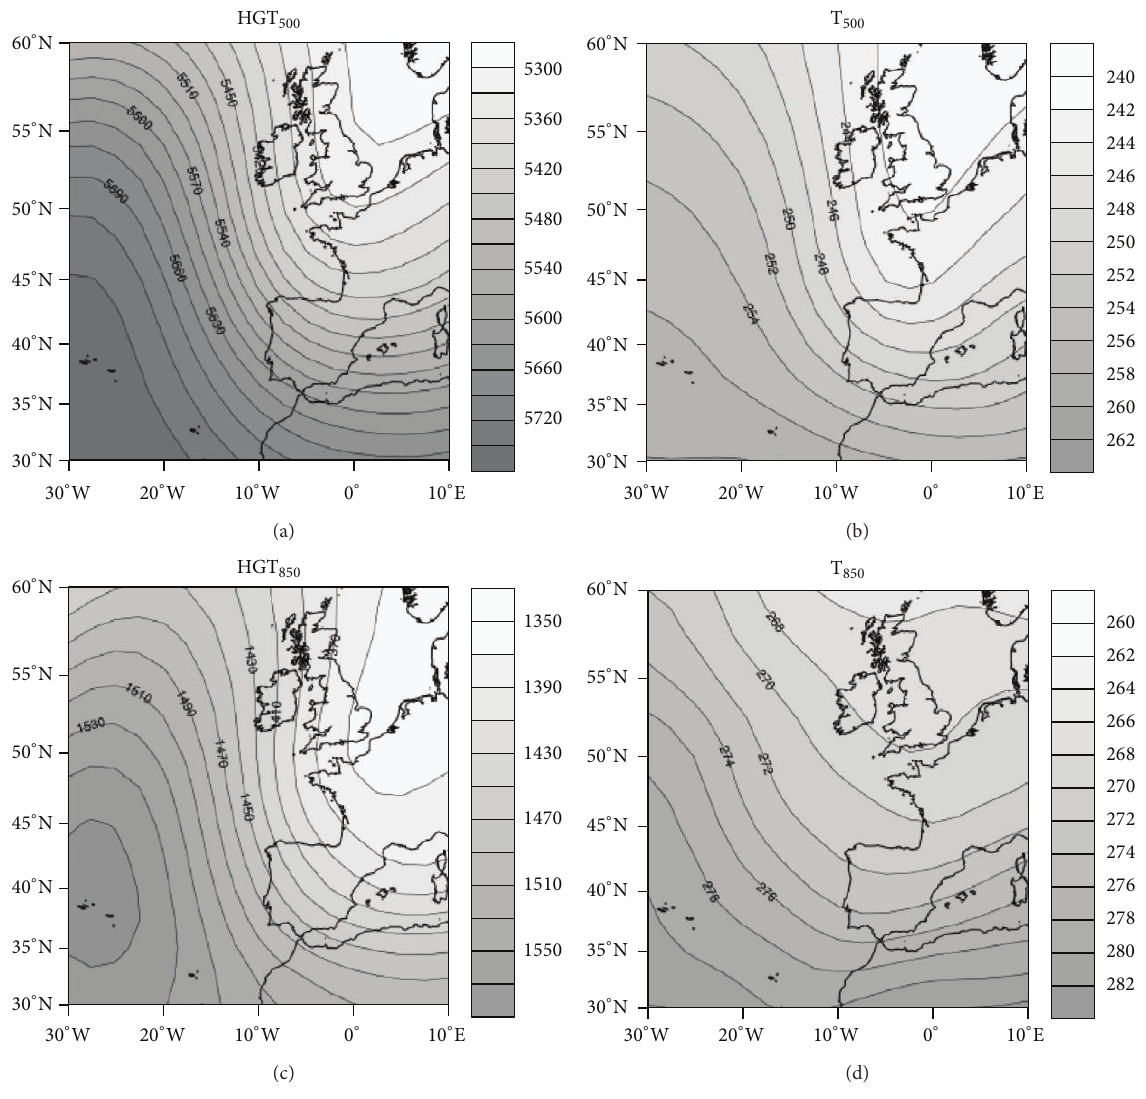
Figure 5: Synoptic environment of cluster 1. Geopotential height (HGT) and temperature (T) at 500 hPa (a, b) and 850 hPa (c, d).